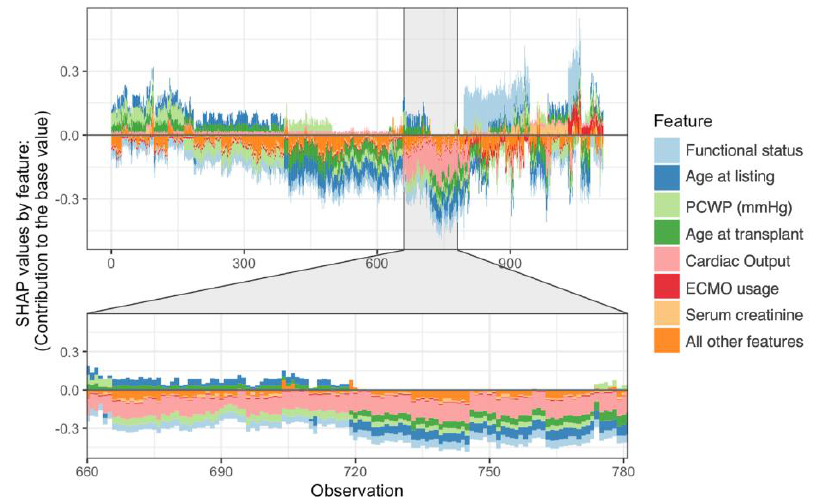
Figure 4. SHAP force plot of the top 7 most important features, by mean SHAP value, with all other features grouped together (orange bars). The x -axis represents each patient in the development co- hort. This plot contains information about how features contributed to model prediction for each observation. Bars further away from a SHAP value of zero, in either positive or negative direction, mean that the feature contributed more to the model. Features with negative SHAP values predicted